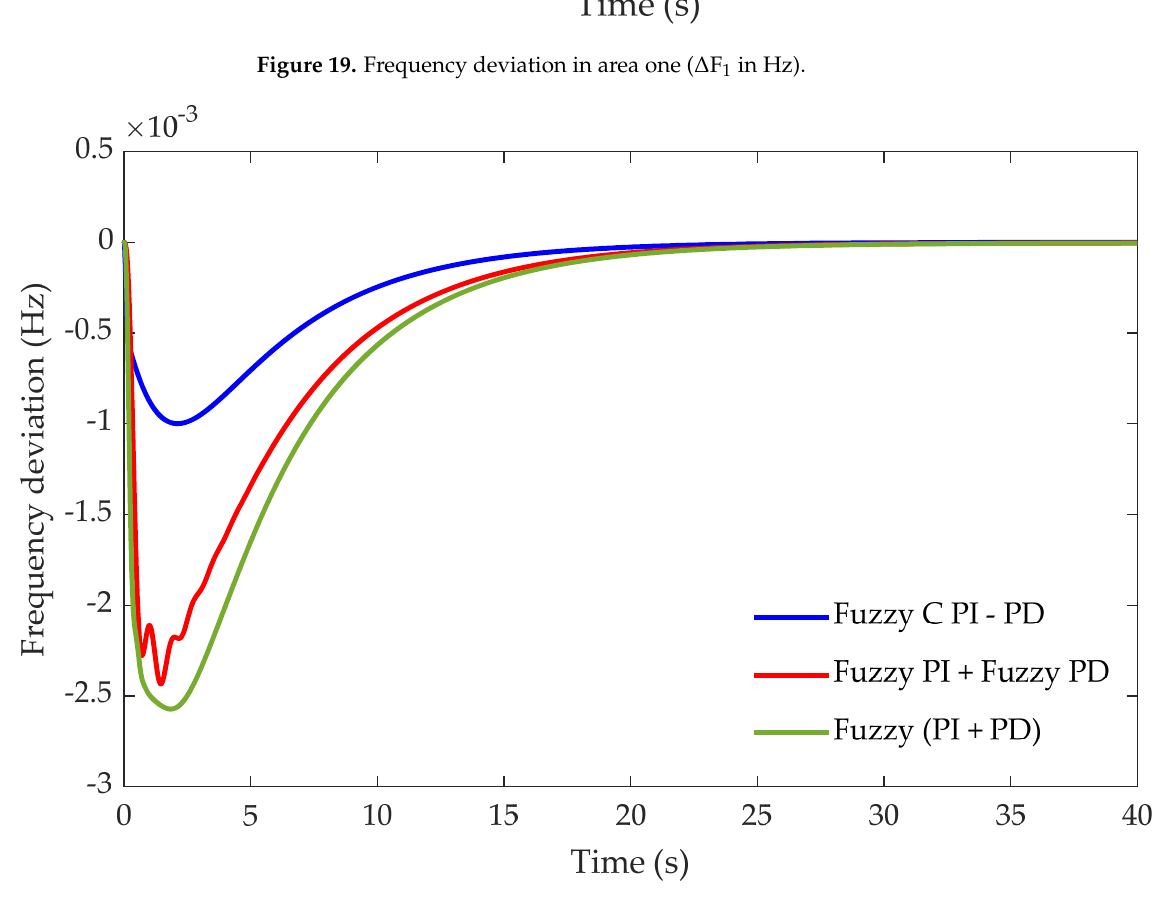
Figure 20. Frequency deviation in area two ( ∆ F 2 in Hz).